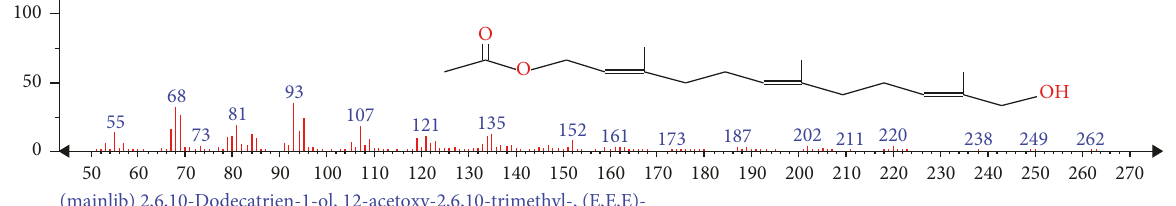
Figure 33: Mass spectrum of compound 2,6,10-dodecatrien-1-ol, 12-acetoxy-2,6,10-trimethyl-(E,E,E)- of whole plant hexane fraction of Achillea wilhelmsii (WHFAW).